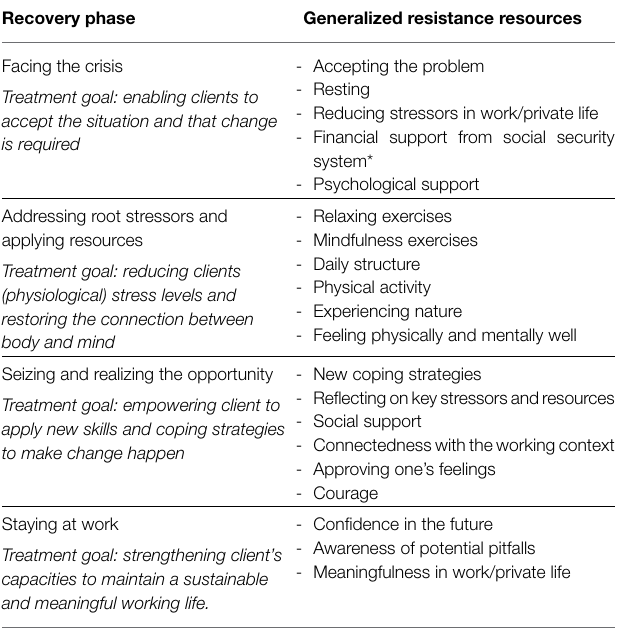
TABLE 1 | Burnout recovery model including key treatment goals and generalized resistance resources (based on: Pijpker et al., 2021; Van Dam, 2021). Recovery